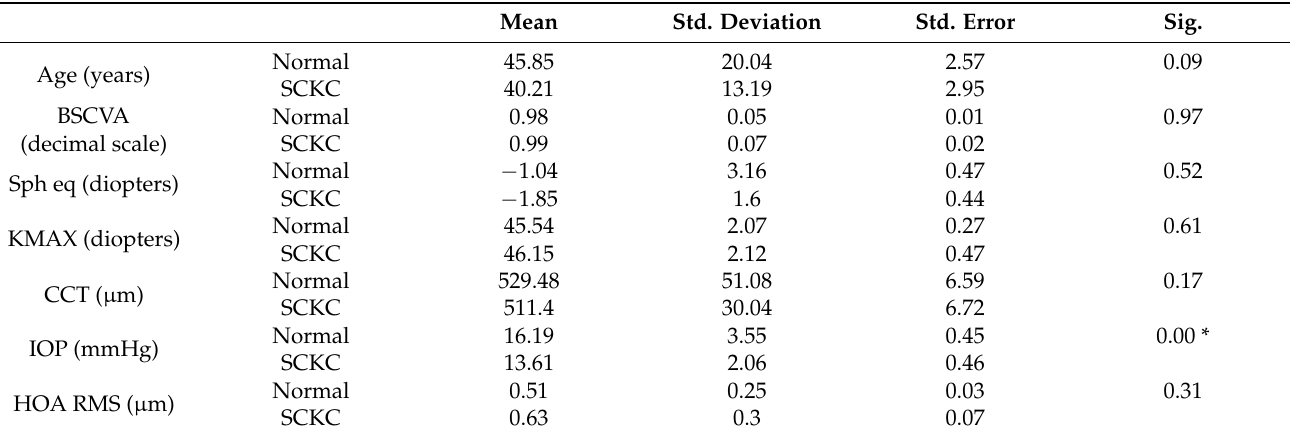
Table 1. Demographics and clinical data.